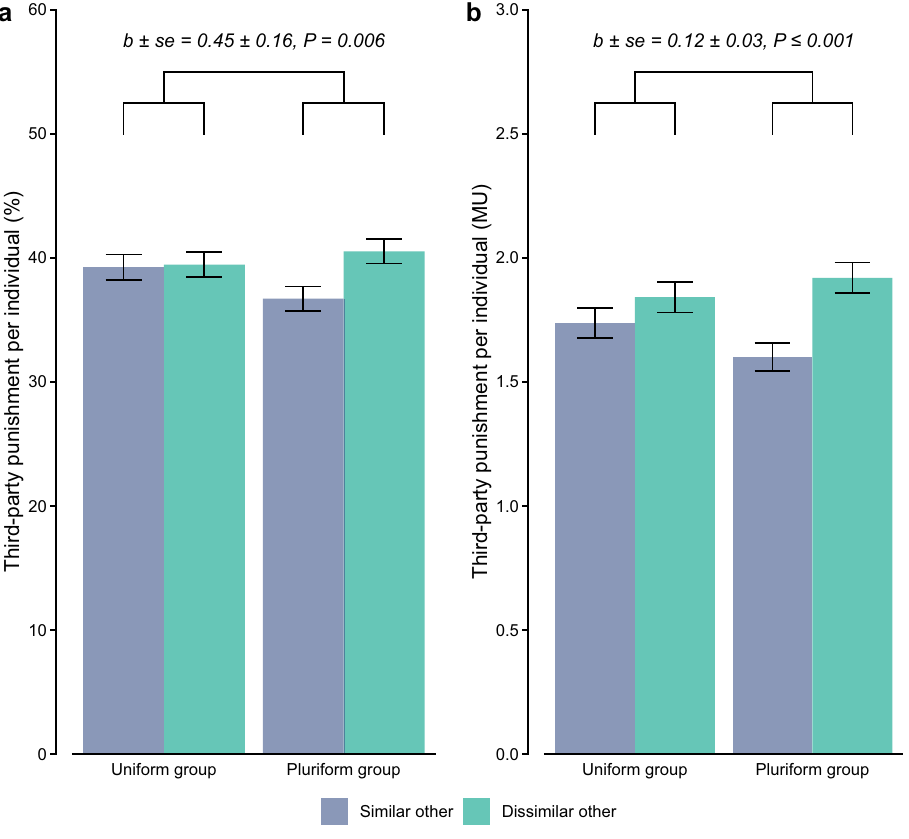
Figure 4. Discriminatory punishment in the pluriform and uniform groups. ( a ) Mean (± se ) frequency of third- party punishment and ( b ) mean (± se ) expenditure on third-party punishment (per individual), as a function of group structure and target’s